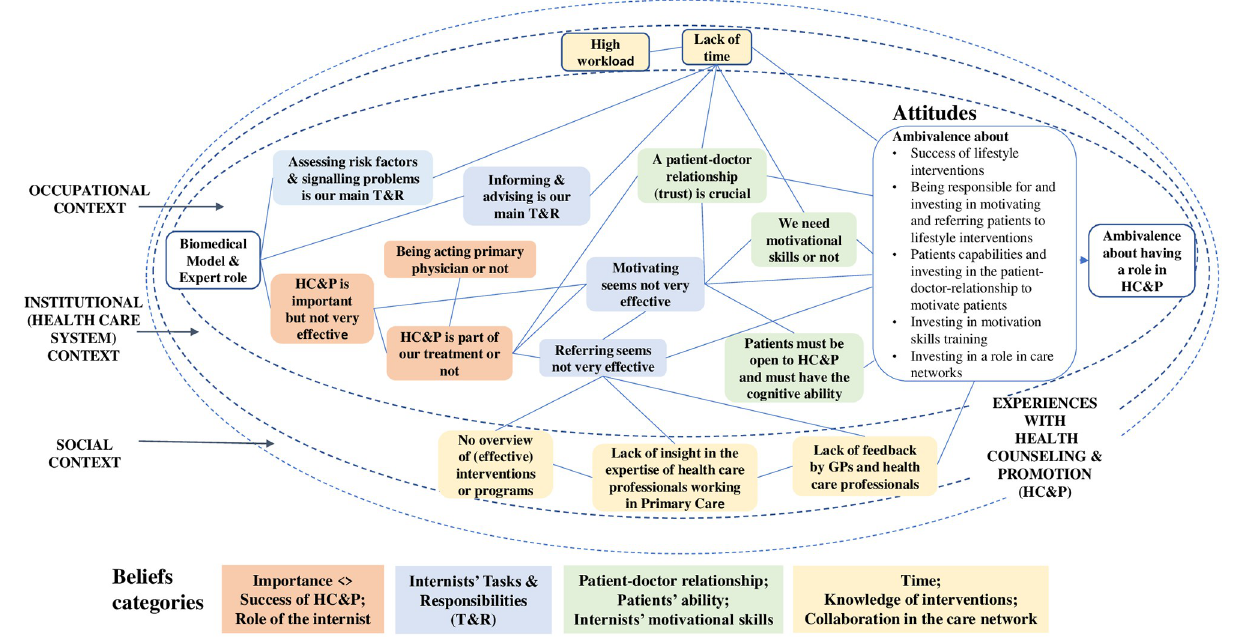
Fig 6. Internists’ beliefs and attitudes regarding their role in Health Counseling and Promotion